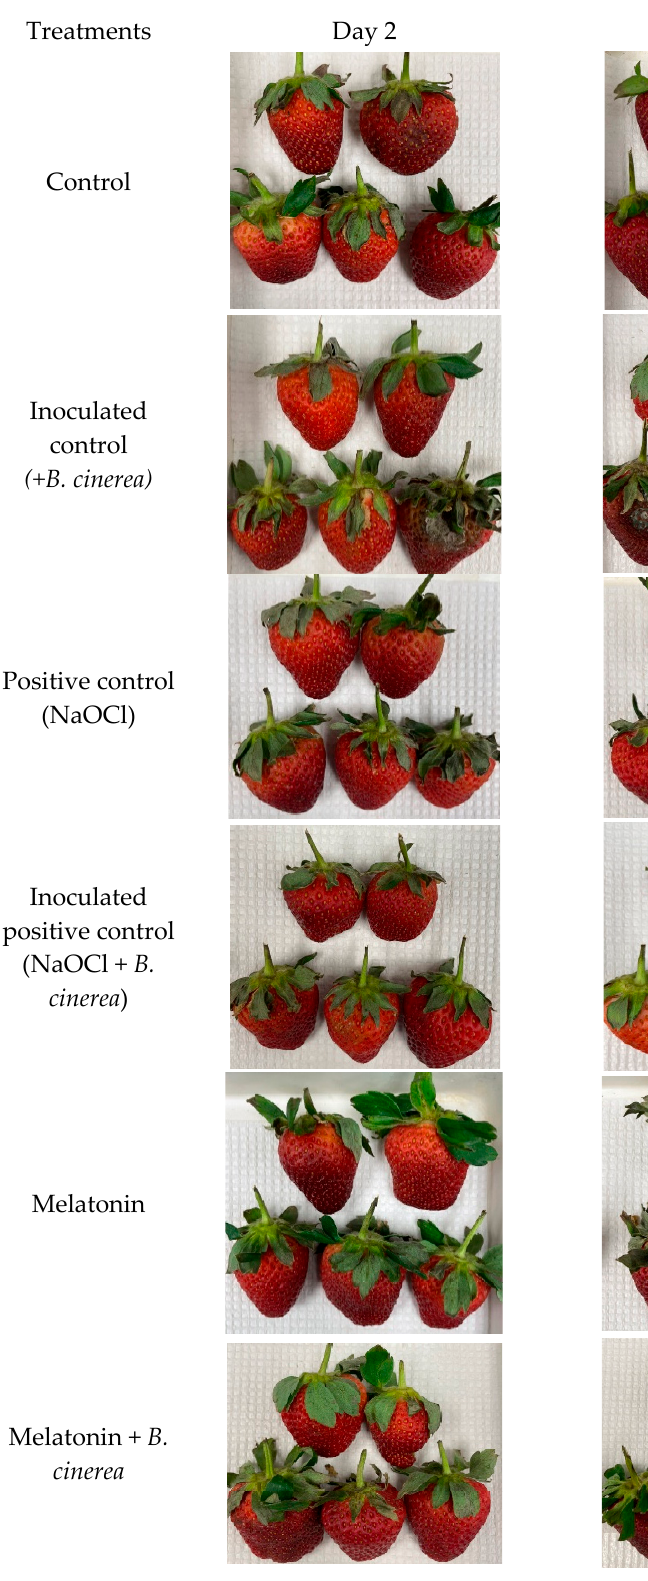
Figure 2. Effect of exogenous melatonin (MT) on the visual appearance of strawberry fruits inoculated with and without Botrytis cinerea, and stored at room temperature (25 ± 2 °C, 80–85% RH) for 6 days.